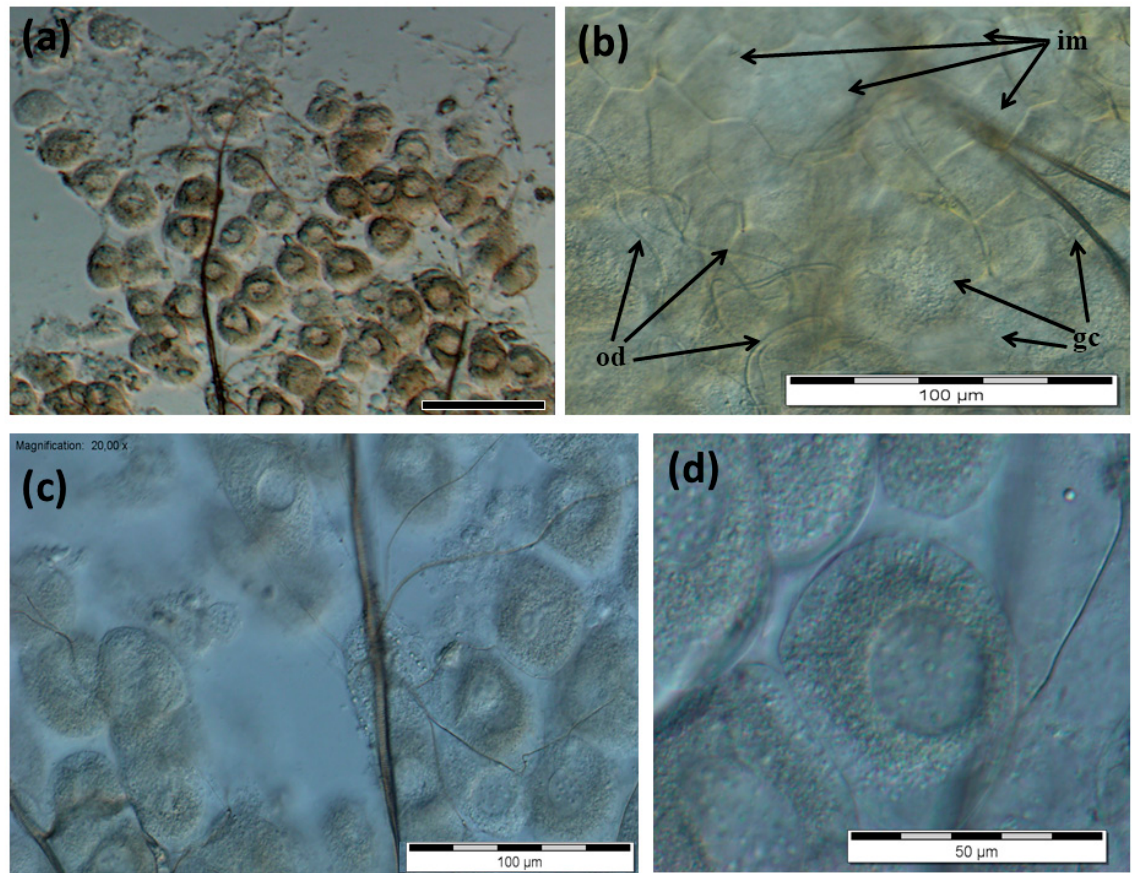
Figure 6. Tergal glands in rebels. ( a – d ) Gland cells; od—outlet ducts; gc—gland cells; im—intersegmental membrane .